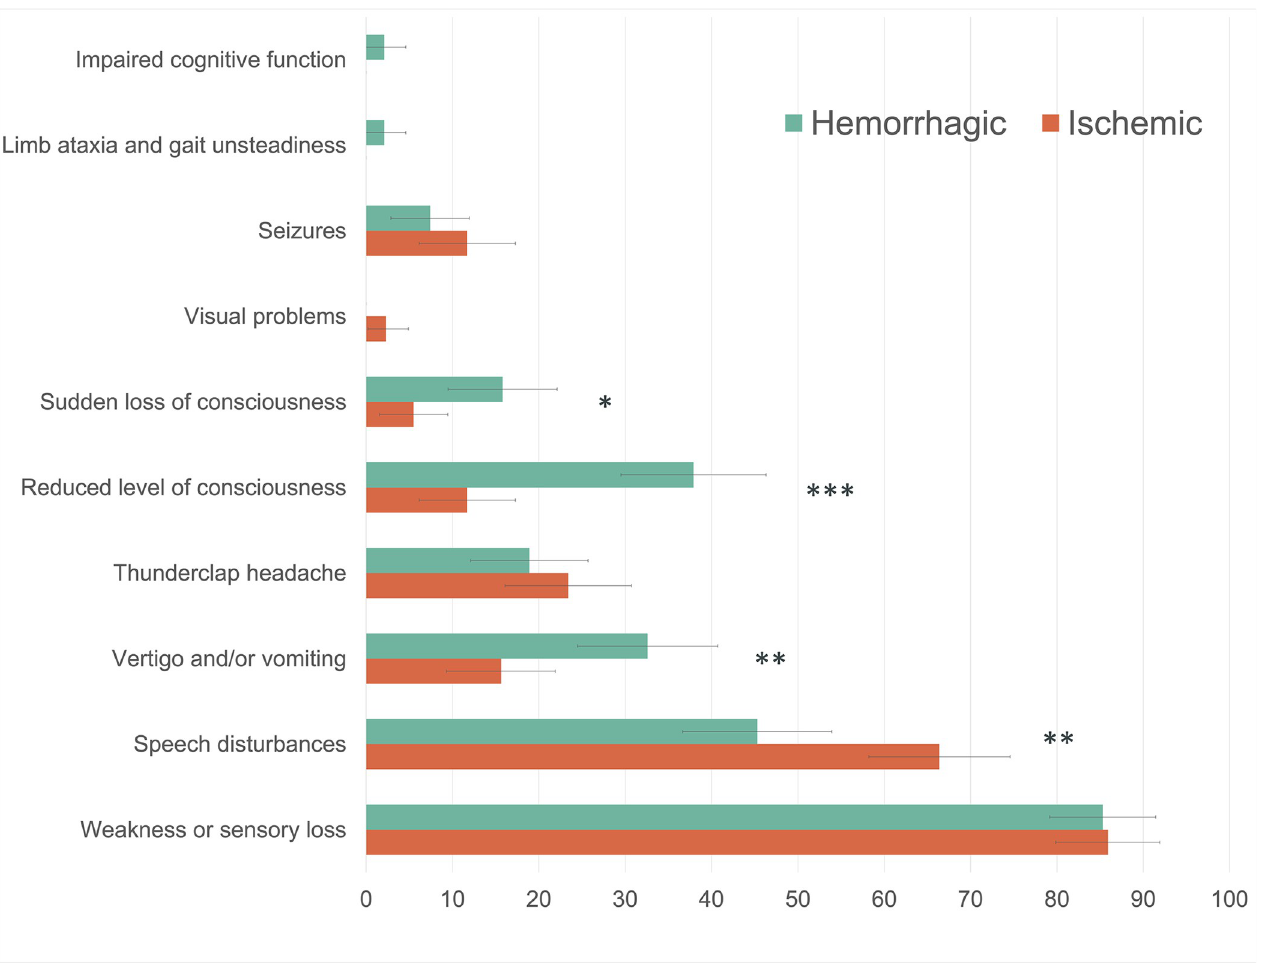
Fig 1. Symptoms of patients with CT-confirmed stroke upon presentation in the emergency room by stroke type. Chi-square: � p < 0.05; �� p < 0.01; ��� p < 0.001.